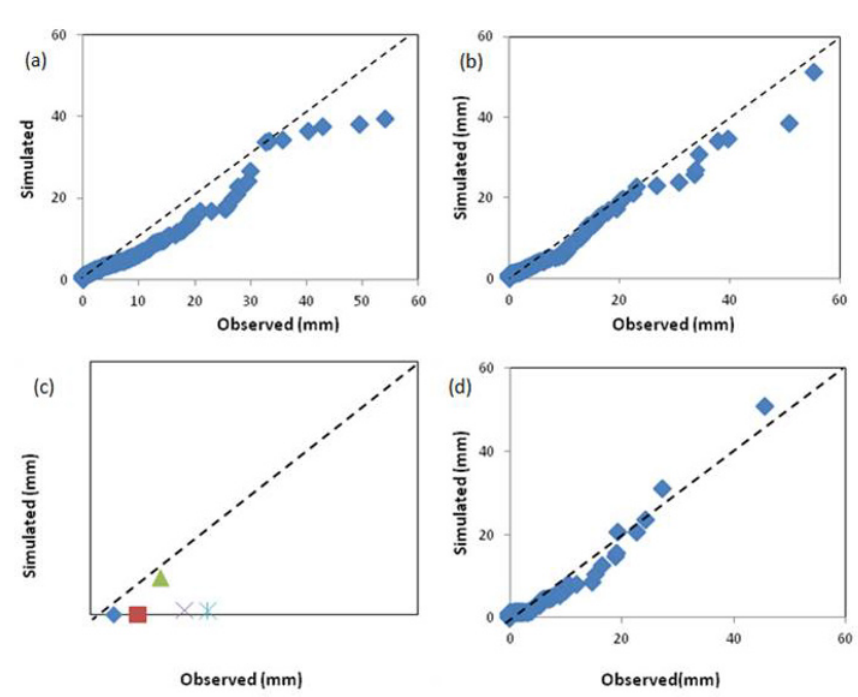
Figure 6. Quantile â€Ș Quantile plot for observed & simulated daily rainfall for (a) winter (b) spring, (c) summer and (d) autumn during calibration and validation periods